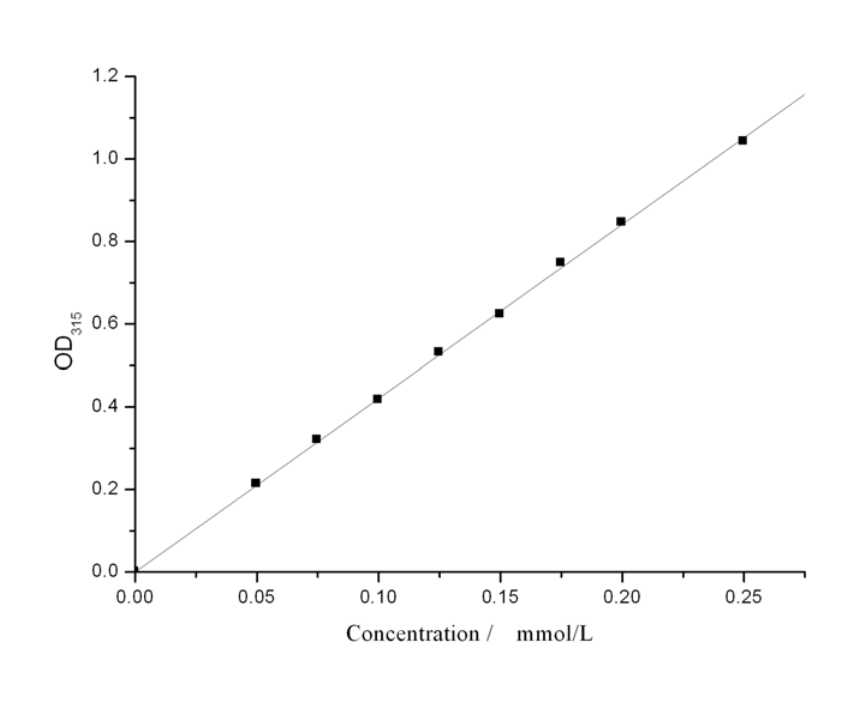
Fig. 1 Standard curve of alicylaldehyde